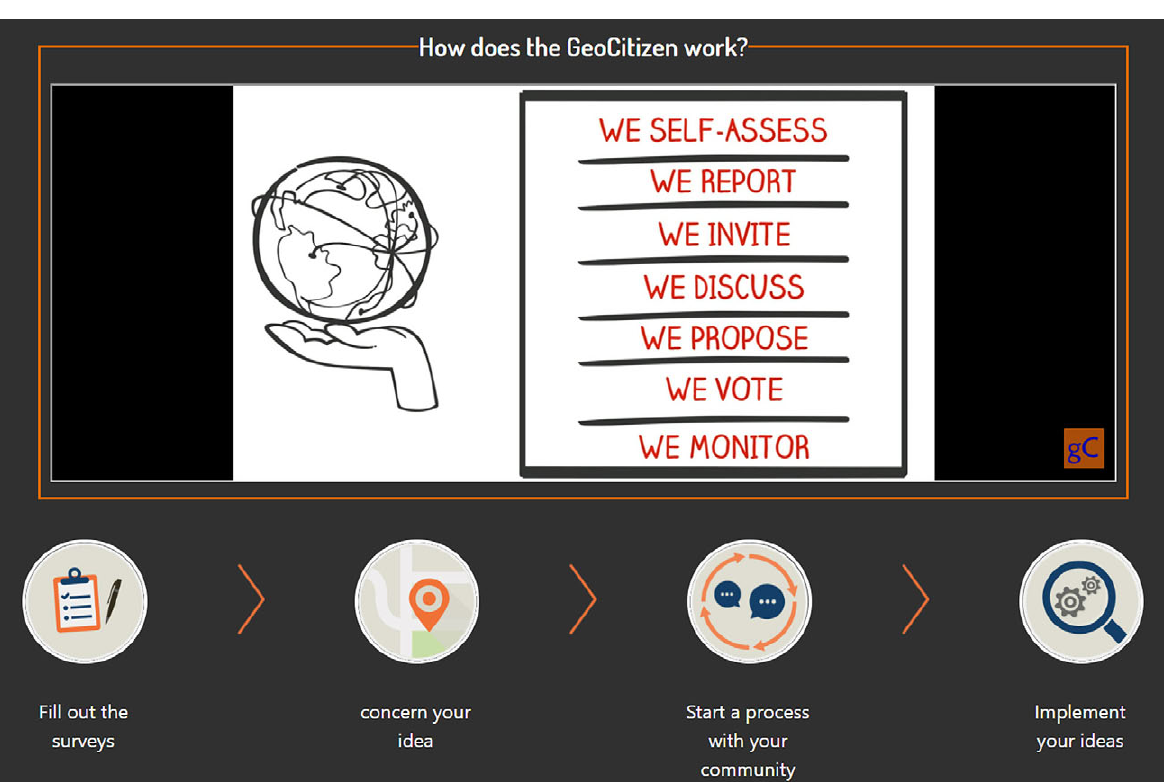
Fig. 3. Workflow for the GeoCitizen Platform (by Fundación CEC and Z-GIS